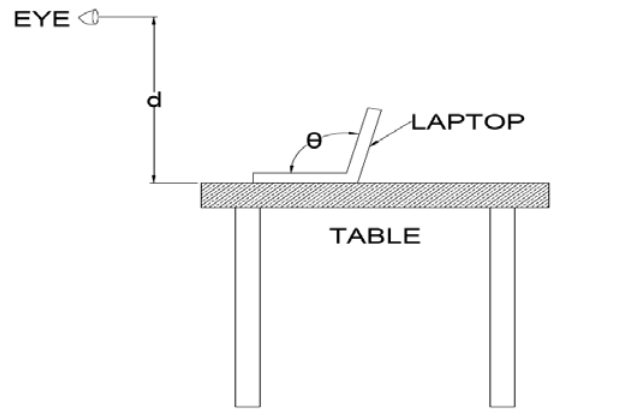
Fig. 1. Arrangement for Experimental